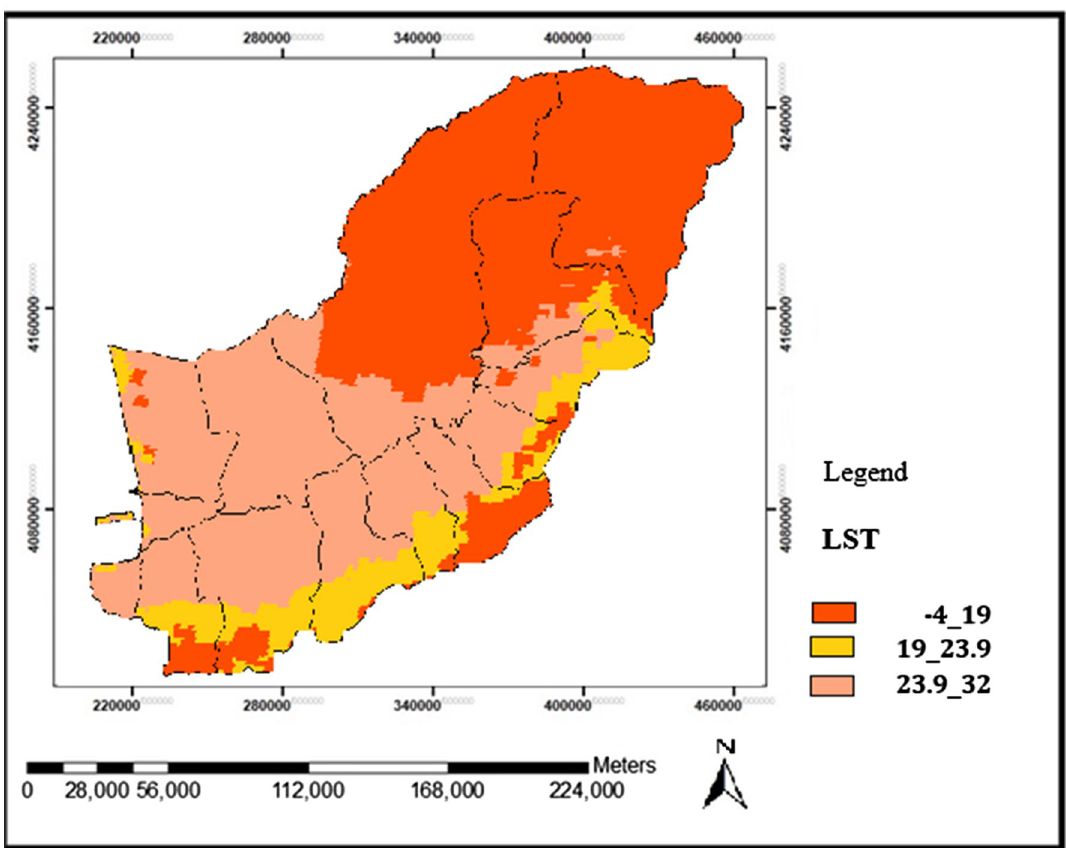
Fig. 5 Average LST index of Golestan province in winter from 2005 to